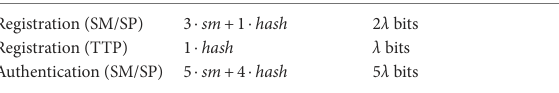
TABLE 3 Analysis about